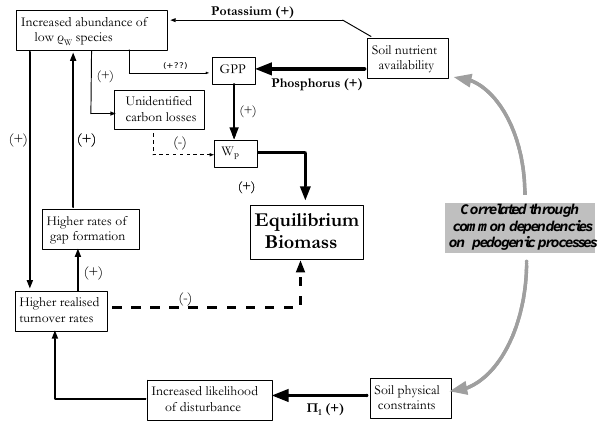
Fig. 16. Differential effects of soil nutrients and adverse soil phys- ical conditions (as quantified through the empirical index 5 1 ) on above-ground coarse wood productivity ( W P ) turnover rates and wood density ( % w ). GPP = Gross Primary Productivity: the annual rate of carbon gain by the stand through photosynthesis.